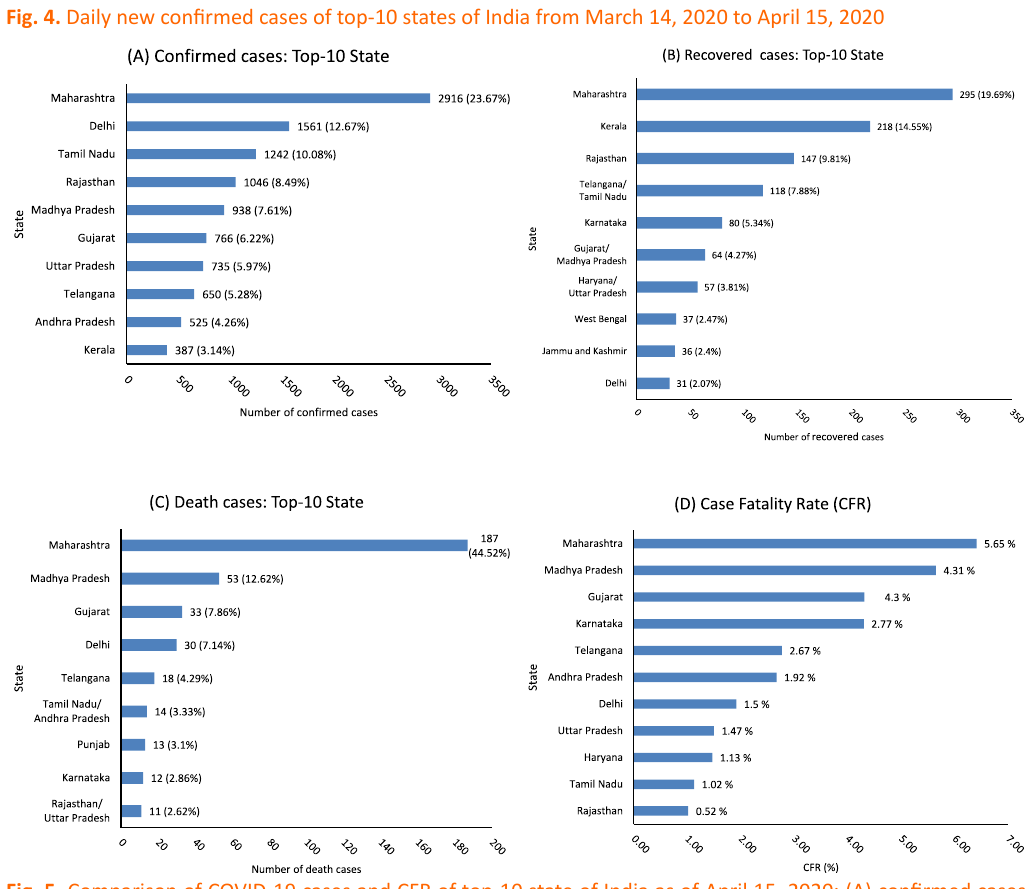
Fig. 5. Comparison of COVID-19 cases and CFR of top-10 state of India as of April 15, 2020; (A) confirmed cases, (B) recovered cases, (C) death cases, and (D) CFR.